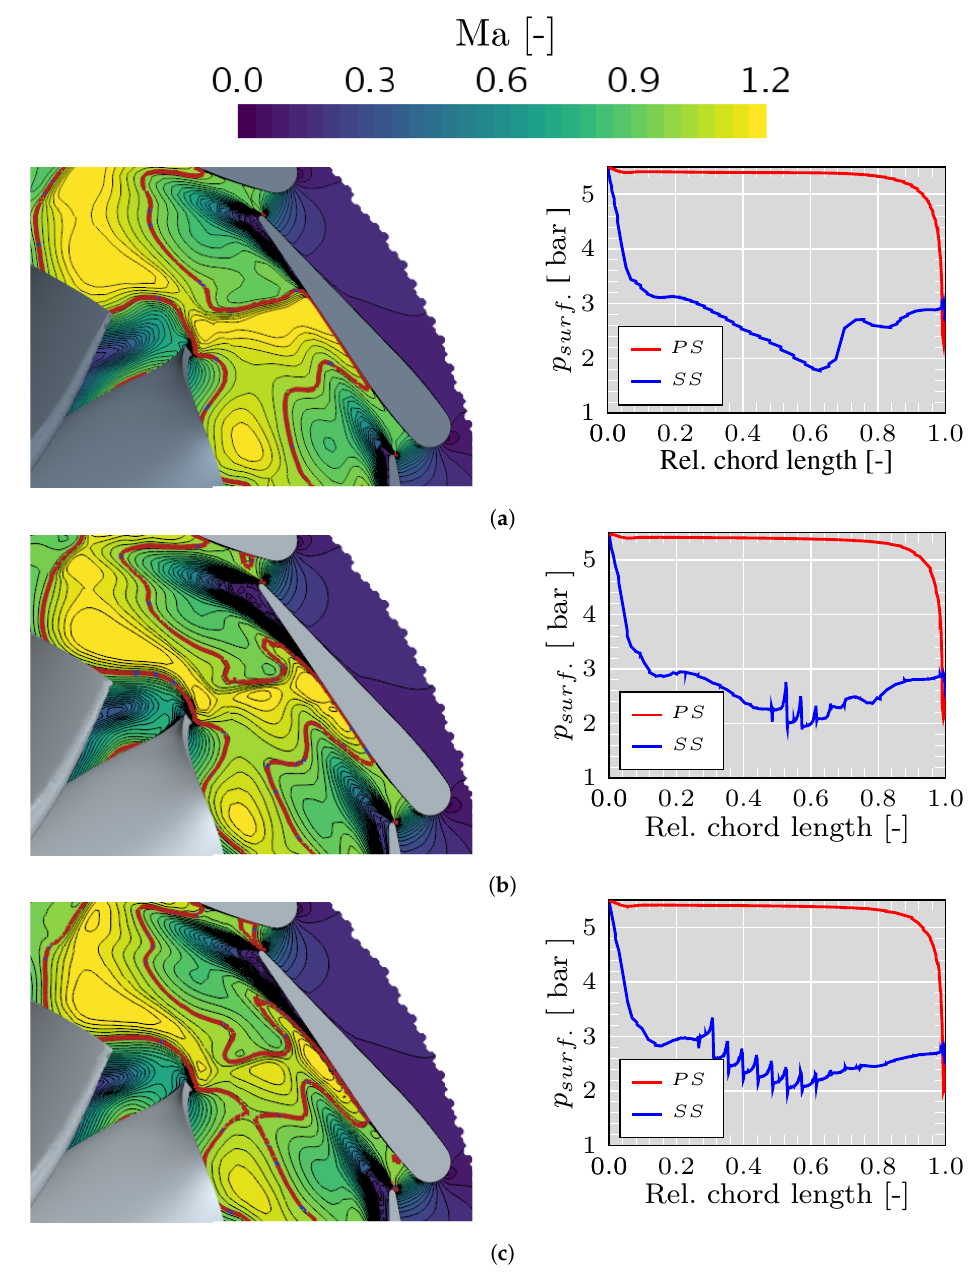
Figure 10. Mach number and stator vane pressure profile snapshots of URANS simulations at 50% span of the stator passage with closed VGT position at lower speed and higher PR; red line: Ma = 1. ( a ) Geometry with 0 grooves (original configuration). ( b ) Geometry with 5 grooves in the stator vanes. ( c ) Geometry with 11 grooves in the stator